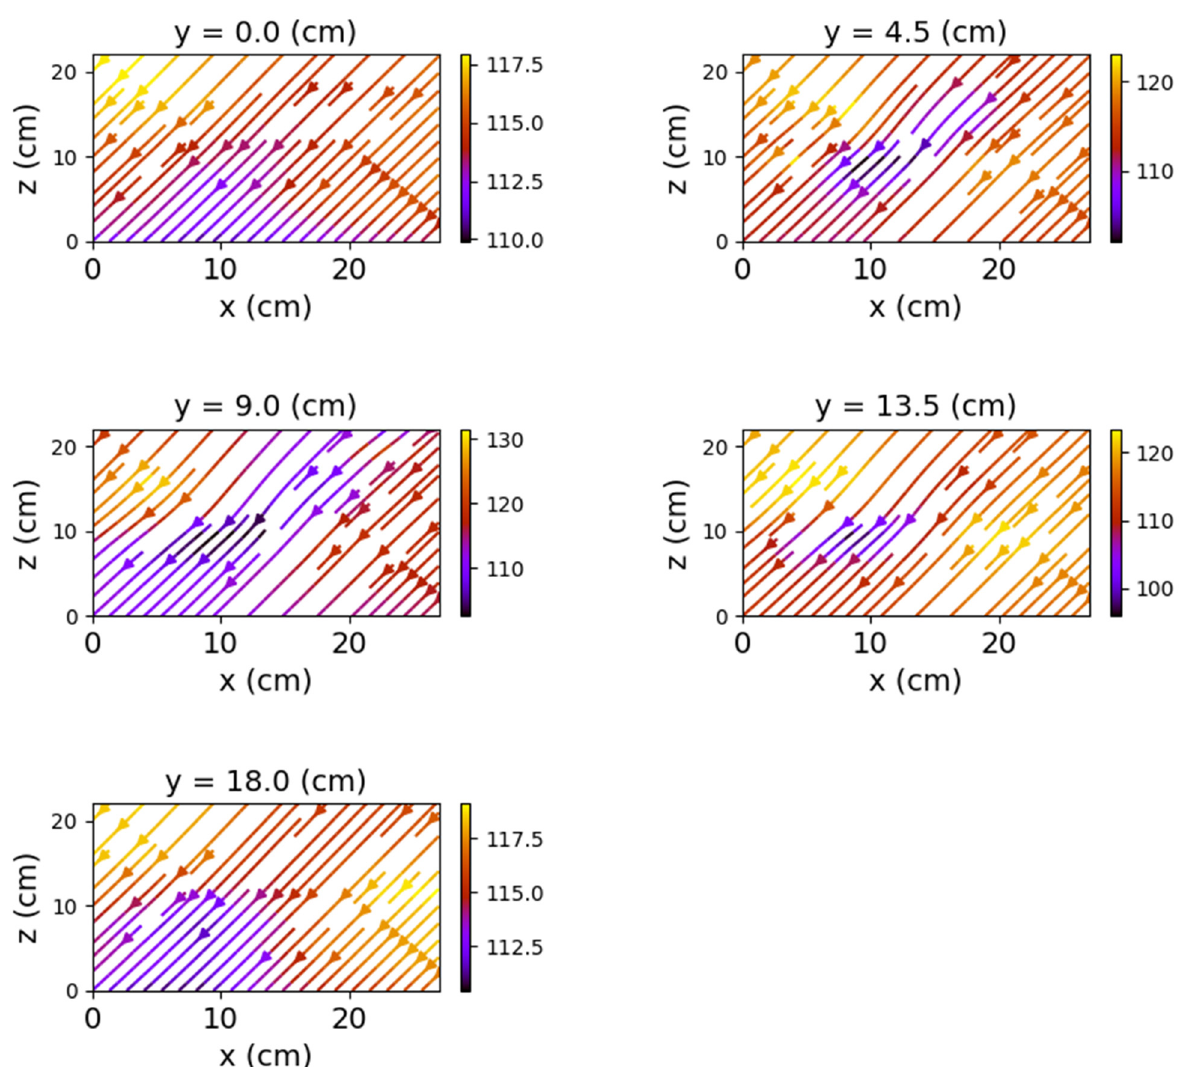
Figure 10. Field lines for x O z plane—non-powered relay.